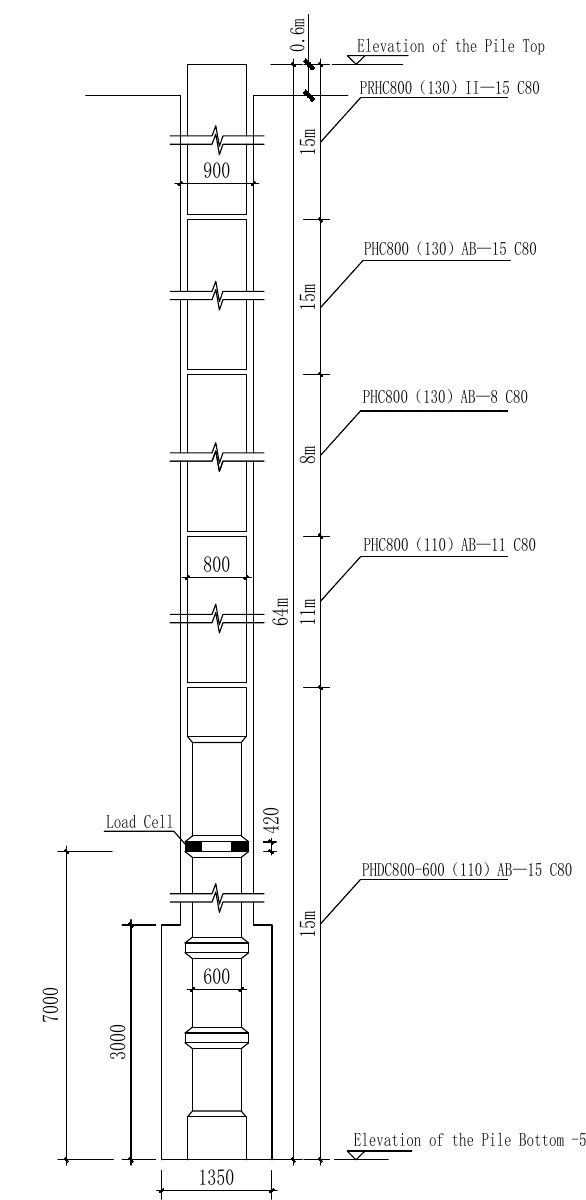
Figure 2. Sketch of the nodular